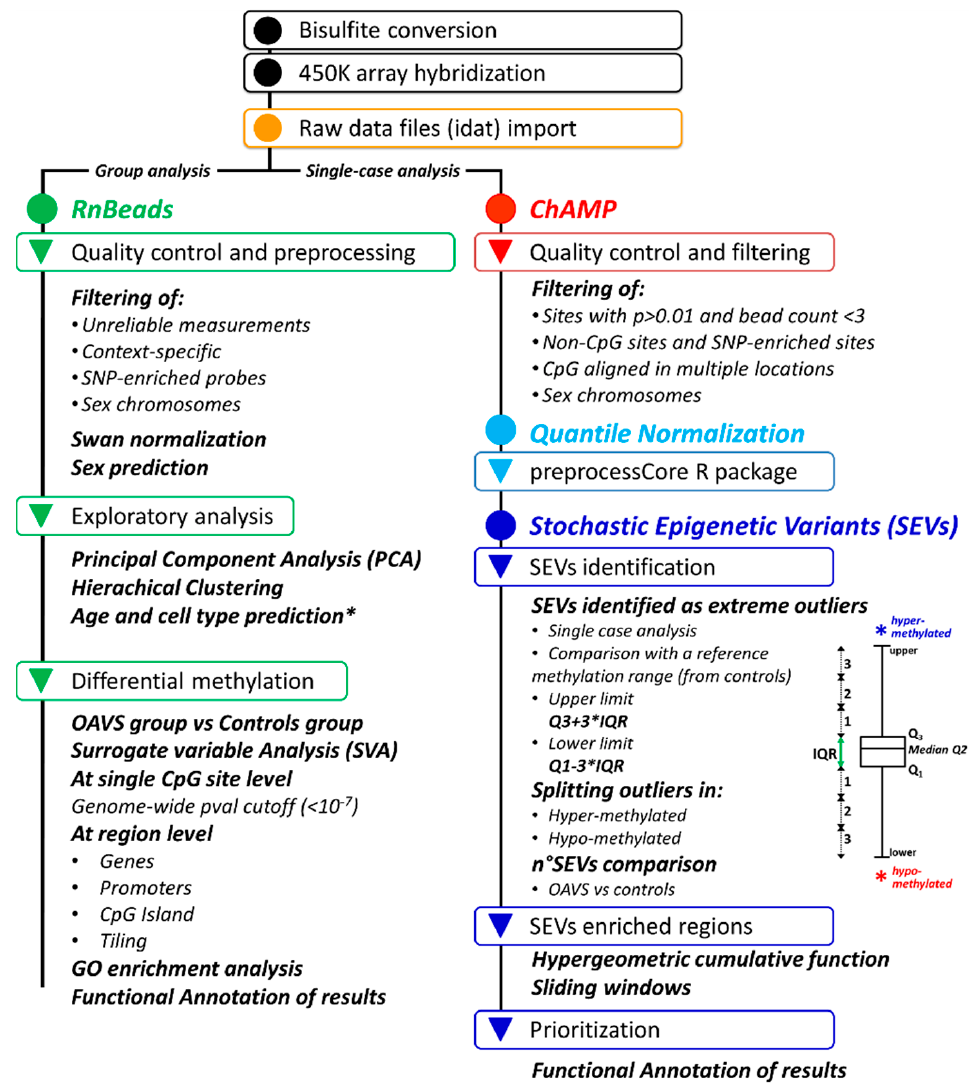
Figure A1. Schematic representation of the multistep analysis pipeline. Genomic DNA was subjected to bisulfite conversion and used for the methylation array procedure. The analysis pipeline has been structured to follow two different but complementary approaches: one (left side) aimed at group comparison by using the integrated functions of the RnBeads package in the R environment. The second one (right side) was structured to analyze single cases through the development of a custom multistep cascade involving both available packages (ChAMP) and homemade scripts. Analyses are described in detail in the methods